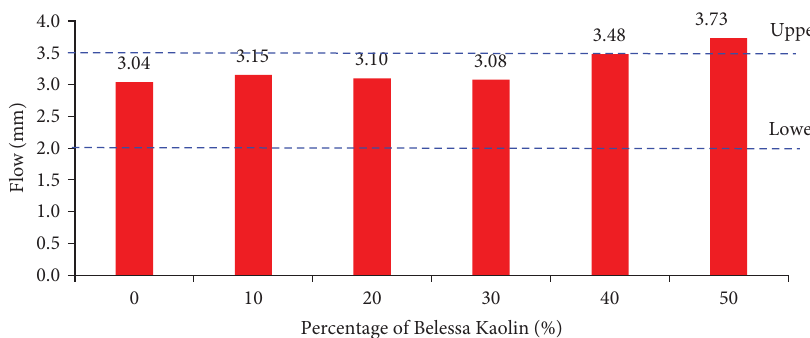
Figure 8: Relationship between fow and replacement proportion of Belessa kaolin at